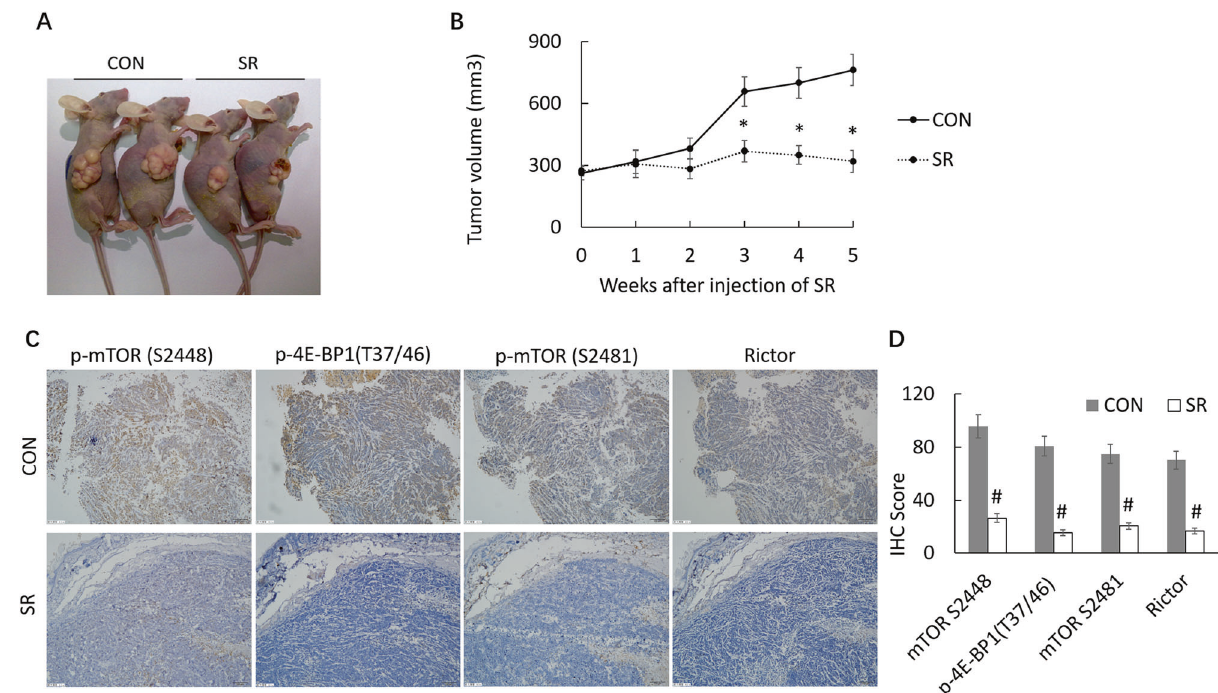
Fig. 4 Effects of SR59230A on mouse xenograft tumors in vivo. A Representative images of nude mice and tumors. B Growth curve of tumors for phosphate-buffered saline or SR59230A treatment group. n = 10 in each group. * P < 0.05 compared with the controls. C , D Immunohistochemical analysis of p-mTOR S2448, p-4E-BP1(T37/46), p-mTOR S2481 and rictor expression in xenografts (×200 magni fi cation), # P < 0.01 compared with the